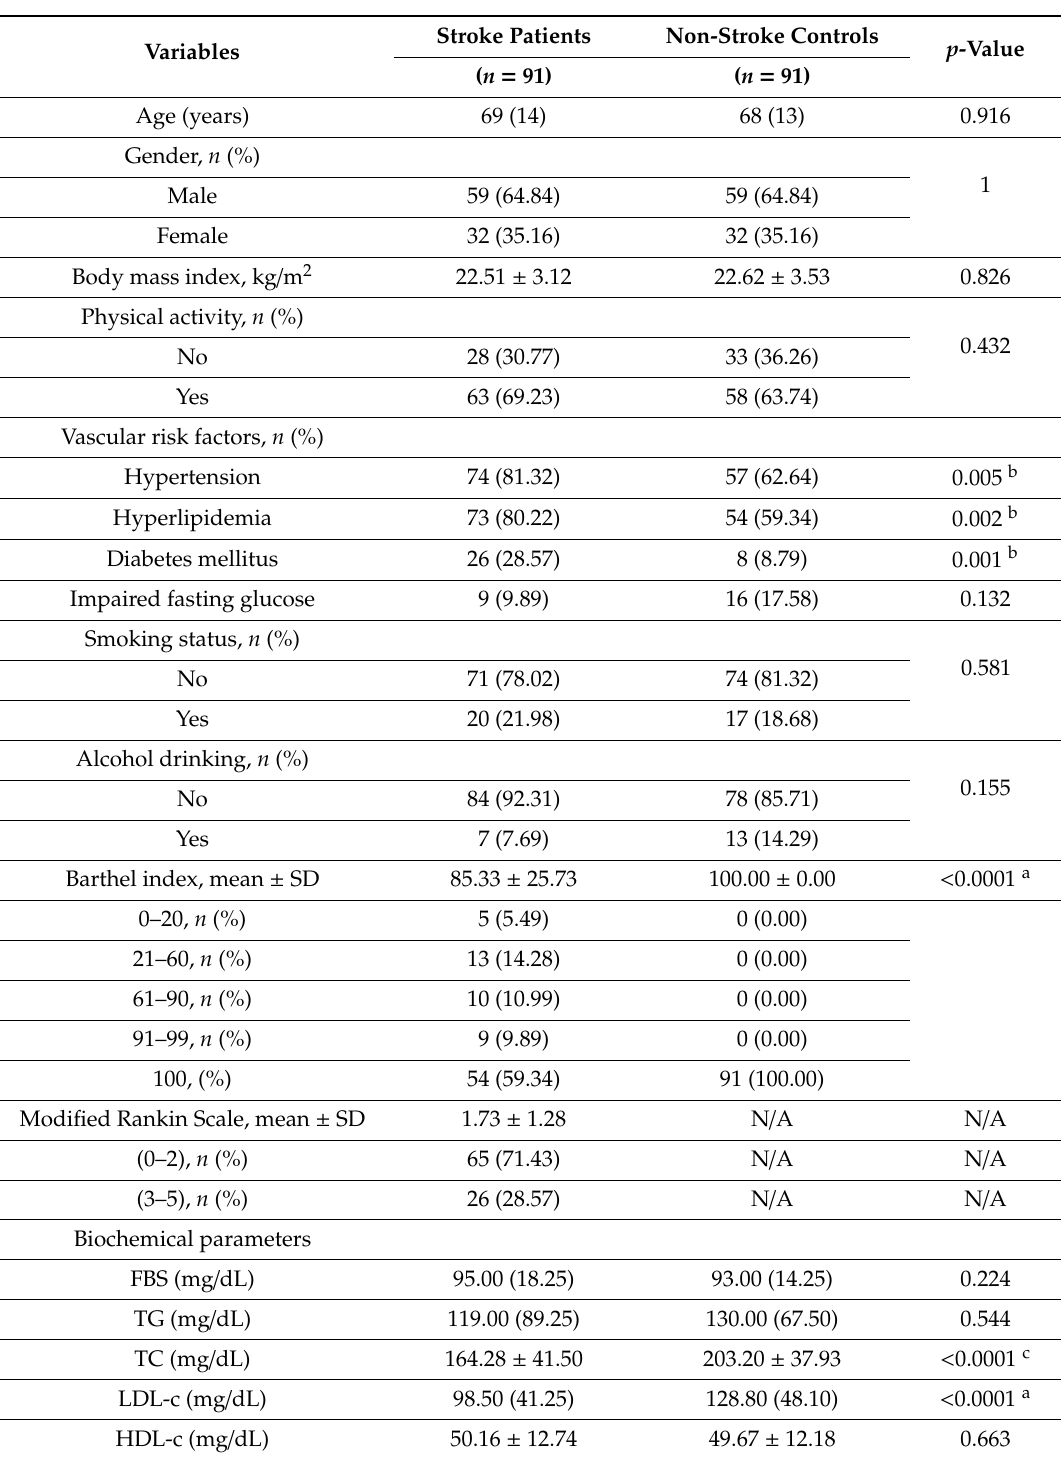
Table 1. Baseline characteristics of non-stroke controls and stroke